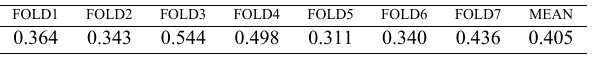
Table 8. RMS errors for the 7 folds (fuzzification parameters defined by experts).